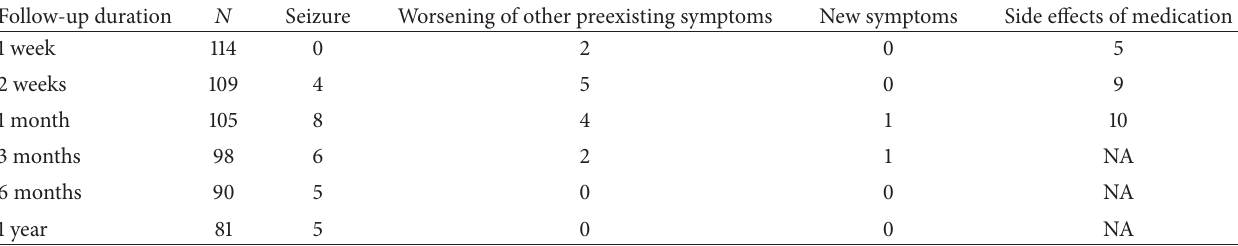
Table 5: Therapy, treatment outcome, appearance of new symptoms, and side effects of therapy in children with neurocysticercosis.